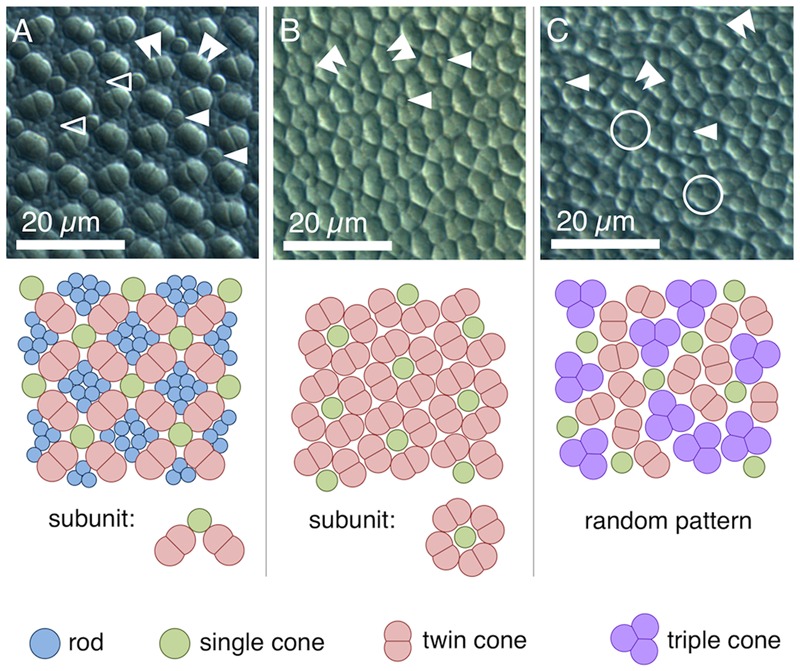
Cone types and mosaic patterns in the retina of T. delaisi. (A) Square mosaic pattern with a 2:1 ratio of twin to single cones, as found across most of the retina. Rods fill in the gaps between cones. (B) Dense, “lucky-clover” pattern with 4:1 ratio of twin cones to single cones and without rods, as found around the fovea. The fovea itself features a modified version of this pattern (Figure 5A). (C) A distinct area between optic disk and fovea features triple cones and a random arrangement of all cone types. Markers in the photomicrographs indicate: open arrowheads – rods; solid single arrowheads – single cones; solid double arrowheads – twin cones; open circles – triple cones.